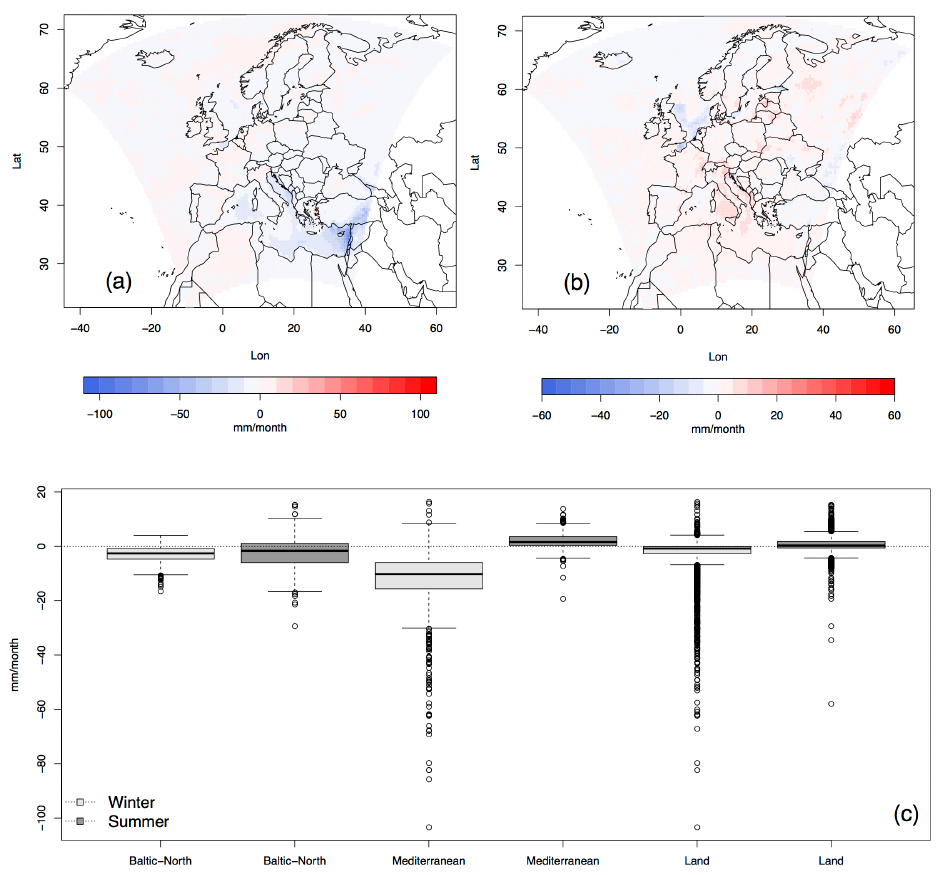
Figure 10. Total precipitation coupled–uncoupled system monthly sum difference averaged over (a) winter and (b) summer for the period 1901–2009. Box plots (c) represent the distribution of these differences over the marginal seas and land separately. The box ends at quartiles, the horizontal line represents the median, and the points are values more than 1.5 times the interquartile range from the end of the box.